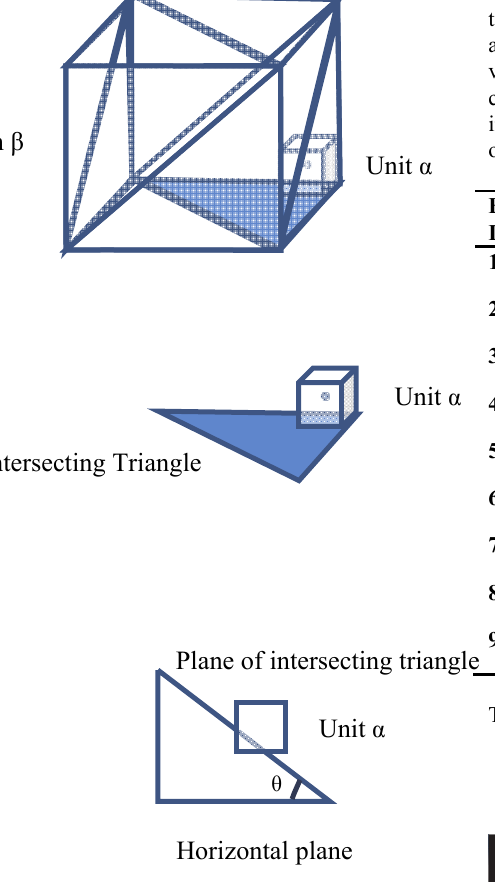
Figure 7. Accessibility evaluation of the unit belonged to the inner space of the building polyhedron